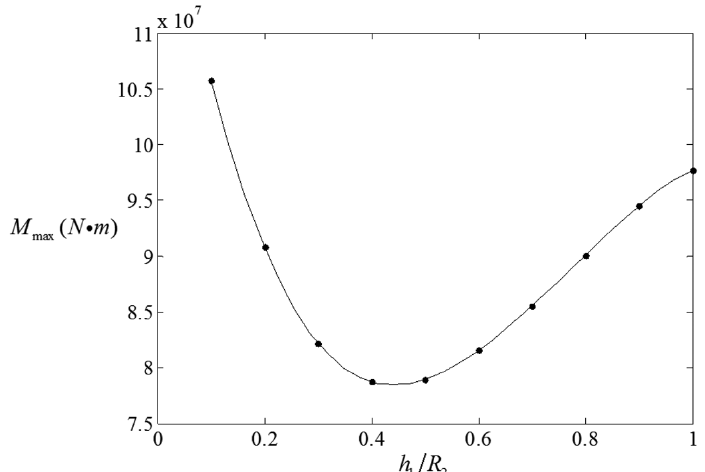
Fig. 17. Maximum amplitude in the time history of the resultant hydrodynamic moment with the center of the bottom of liquid under the Kobe seismic excitation versus h 1 / R 2 for R 1 / R 2 =